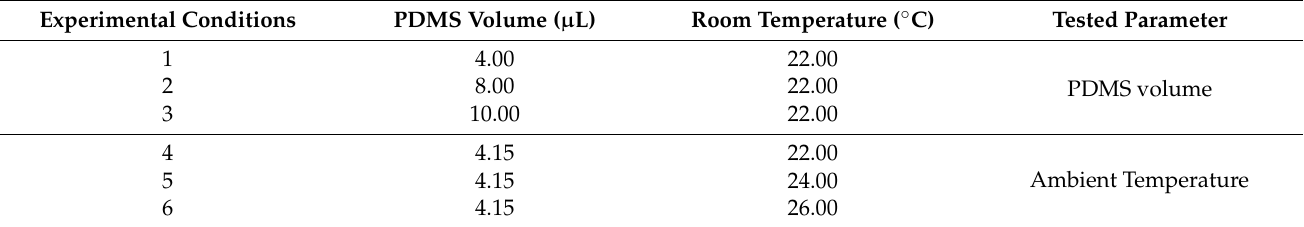
Table 1. Experimental conditions for membrane thickness testing. Two parameters were